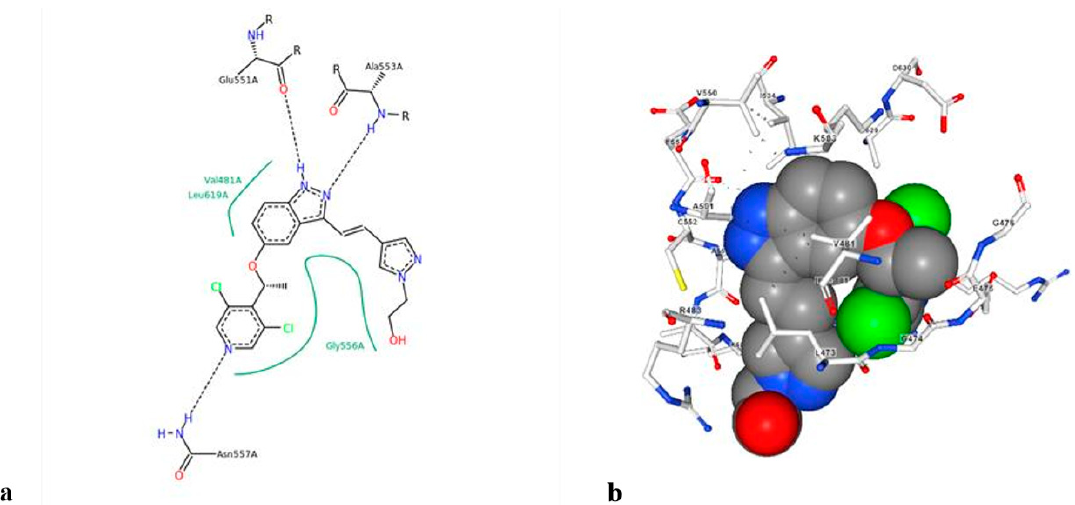
Figure 8. ( a ) Structure of LY2874455, and ( b ) binding mode of LY2874455 with the FGFR4 kinase domain (PDB code 5JKG).